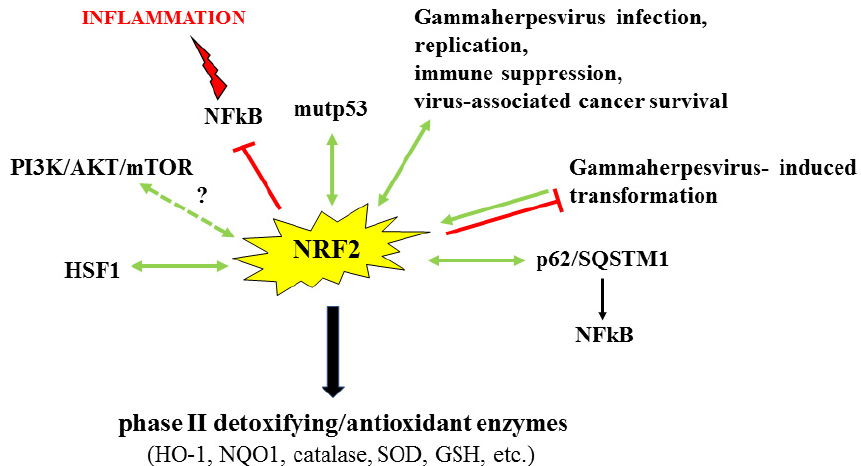
Figure 6. Interplay between NRF2 and oncogenic, pro-survival/inflammatory pathways. Not applicable Schematic representation of the interaction between NRF2 and several pathways that can control each other in a feedback loop. The antioxidant activity of NRF2 and its interaction with those pathways can have a key role in tumor progression.